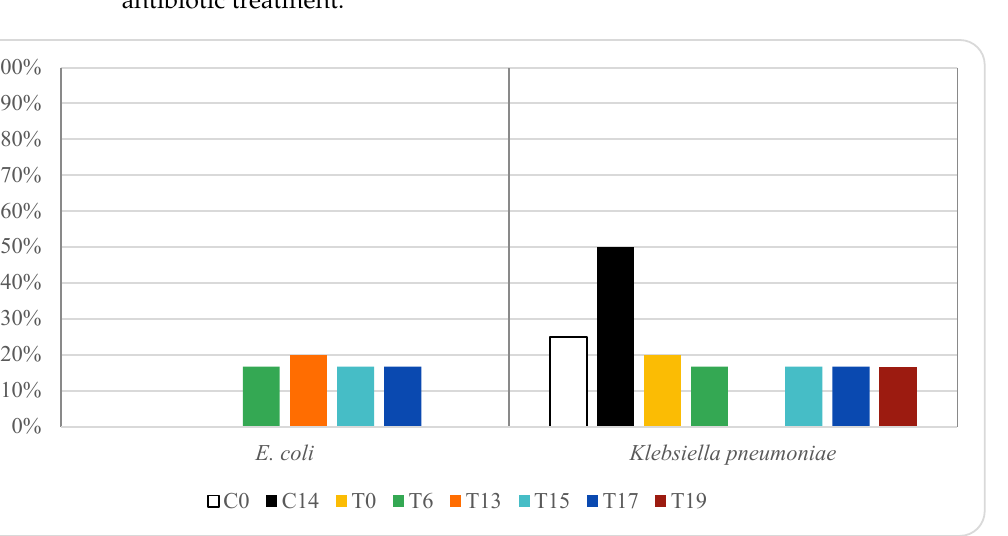
Figure 6. Effect of enrofloxacin treatment on ESBL-producing E . coli and K. pneumoniae in pig rectal samples. For group descriptions C0, C14, E0, E3, E4, E5, E6, E7: see Table 1. Figures 7 and 8 show the percentage of animals in which ESBL-producing E. coli and K. pneumoniae isolates were found in genital samples from pigs treated with oxytetracy- cline and enrofloxacin, respectively. ESBL-producing E. coli was not detected either in genital samples taken from animals treated with oxytetracycline or in samples taken from the control group. However, it was detected in 17% and 33% of the animals treated with enrofloxacin on days 5 and 6, respectively (one and two piglets, respectively). ESBL-producing K. pneumoniae was only detected in the 17% of genital samples col- lected from animals treated with oxytetracycline on day 19 (one piglet), while it was not detected in any animal treated with enrofloxacin. In the control group, it was not detected any positive animal on day 0, while 25% were positive on day 14 (one piglet).